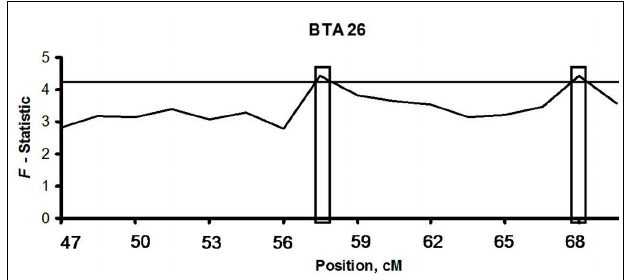
FIGURE 2 | Linkage of bovine respiratory disease with BTA26 with a two locus model in two half-sib sire families. The computed F -statistic is shown on the y -axis and the relative distance between each SNP is given in centimorgans (cM) on the x -axis.The boxed regions identify the two loci linked with bovine respiratory disease ( P < 0.05) after 5,000 permutations. The horizontal line represents the significance threshold of P =